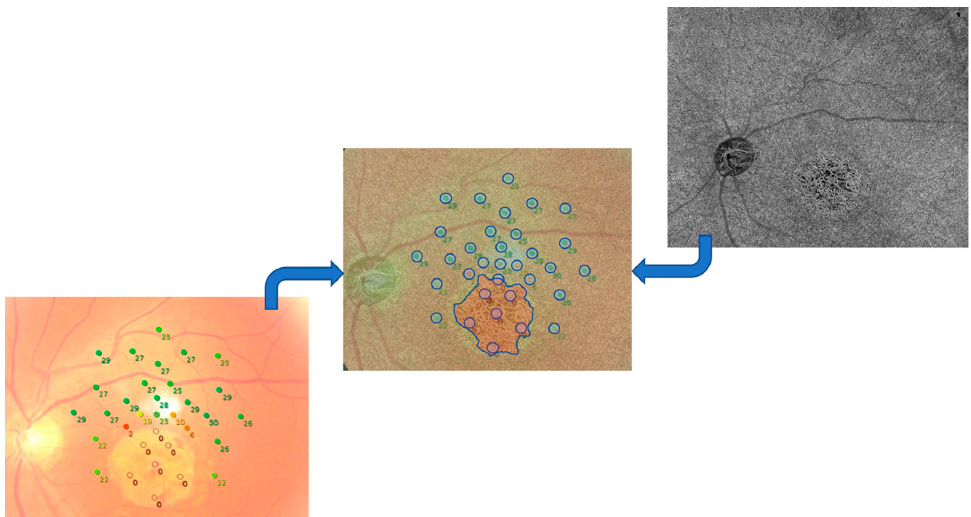
Figure 1. In the center retinography and MP grid overlapped on swept-source-optical coherence tomography angiography (SS-OCTA) choriocapillaris slab (in transparency) after a rigid transformation (OS of patient 1). In blue: circular areas centered on microperimetry (MP) points and the borders of the central atrophic area.